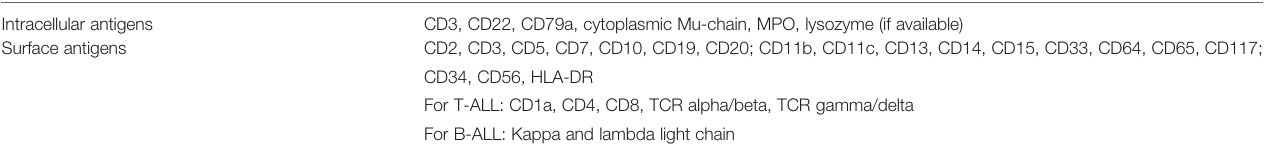
TABLE 4 | AIEOP-BFM consensus antibody panel for pediatric ALL (22). Intracellular antigens CD3, CD22, CD79a, cytoplasmic Mu-chain, MPO, lysozyme (if available) Surface